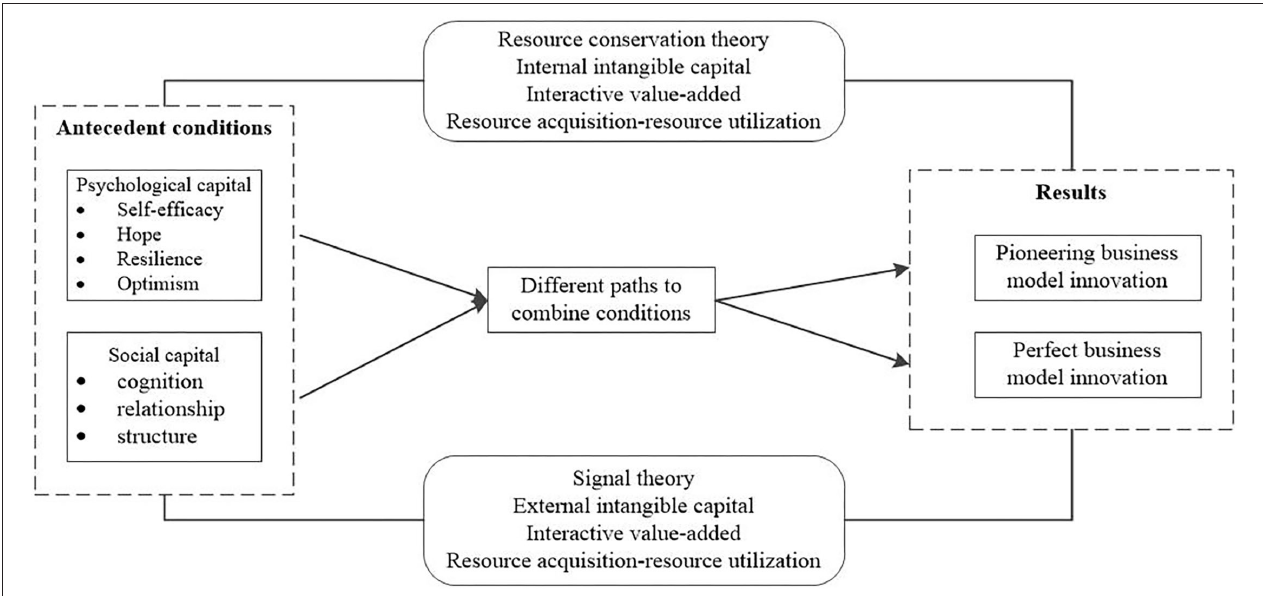
FIGURE 1 | Research